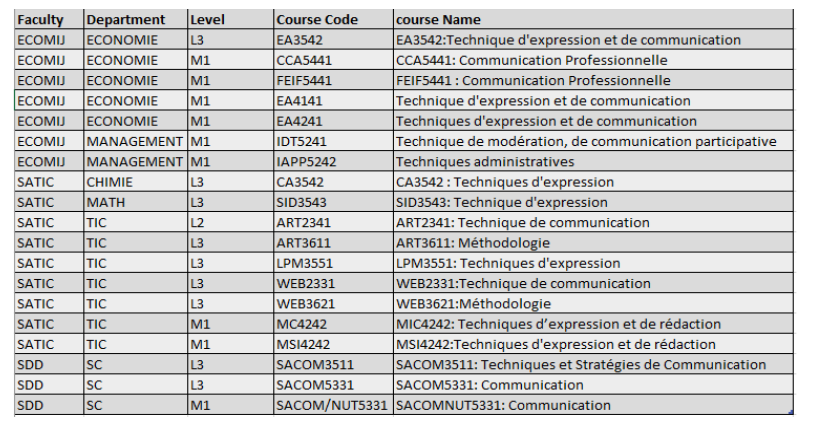
Fig. 2. Classification of the cross-cutting components by level, department and faculty for